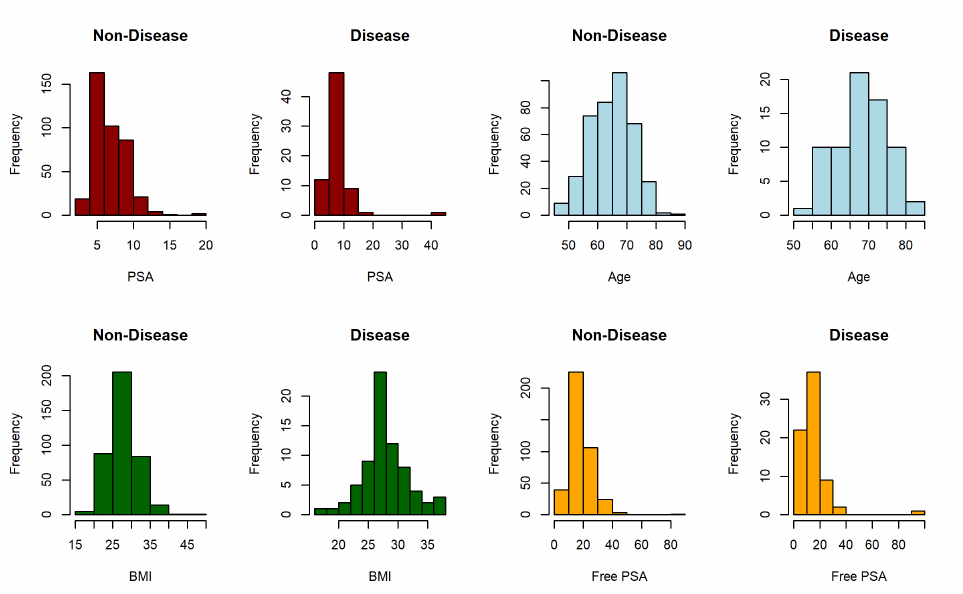
Figure 2. Marginal distributions of biomarkers. Prostate cancer dataset. PSA: prostate specific antigen, Age: age in years, BMI: body mass index, Free PSA: percentage of Free PSA.